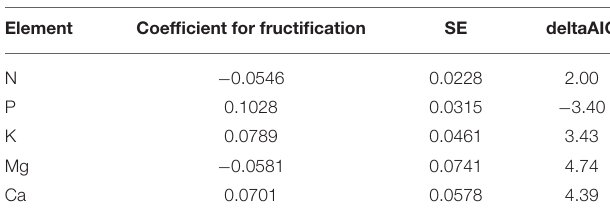
TABLE 5 | Regression coefficients of the relation between foliar nutrient concentration and long-term average of fructification per tree (average year